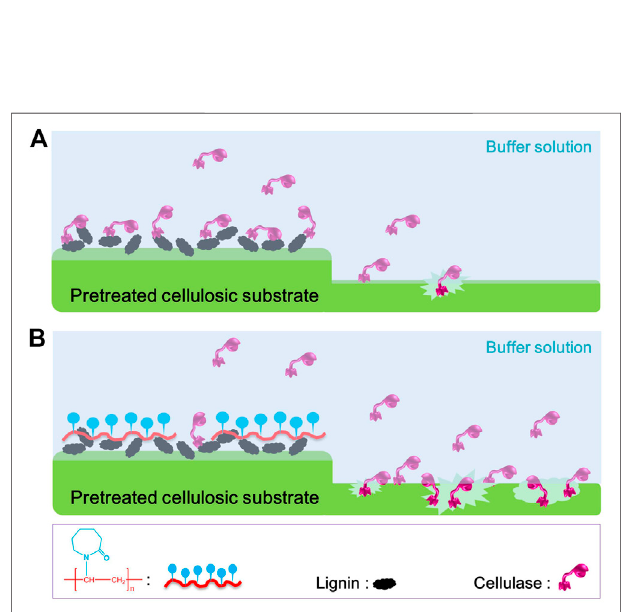
FIGURE 7 | Proposed mechanisms for (A) the inhibition of PSA lignin and (B) promotion of PNVCL to the enzymatic hydrolysis ef fi ciencies of PSA- Ba